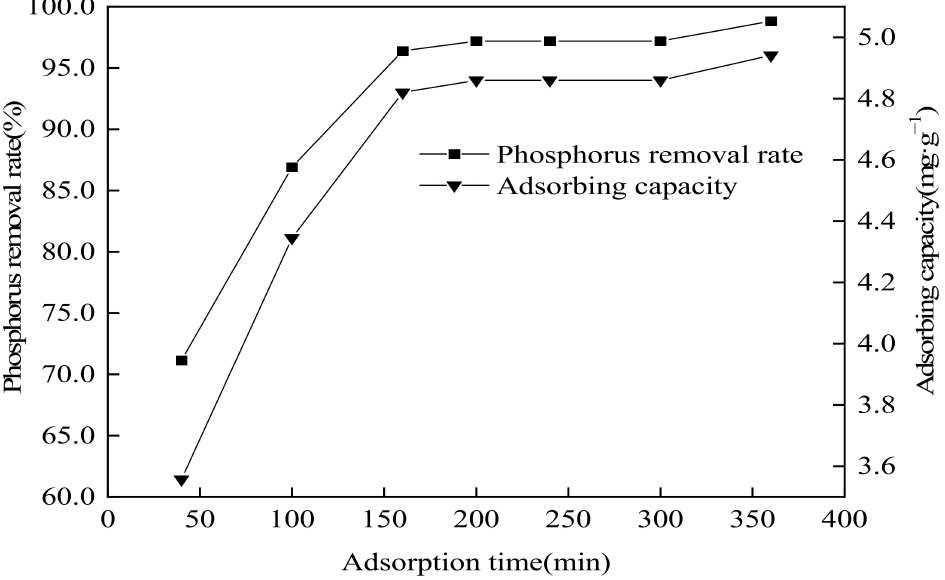
Figure 8. Effect of adsorption time on phosphorus removal